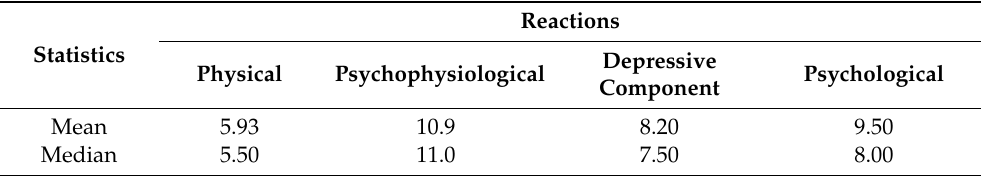
Table 4. Infantile Stress Scale per reaction in the context of the COVID-19 pandemic, of students from the 2nd year to the 9th year of the Basic Level of private schools in Santar é m, Par á , Brazil. Reactions Statistics Depressive Psychological Physical Psychophysiological Component Mean 5.93 10.9 8.20 9.50 Median 5.50 11.0 7.50 8.00 Source: Data Bank of this Research.